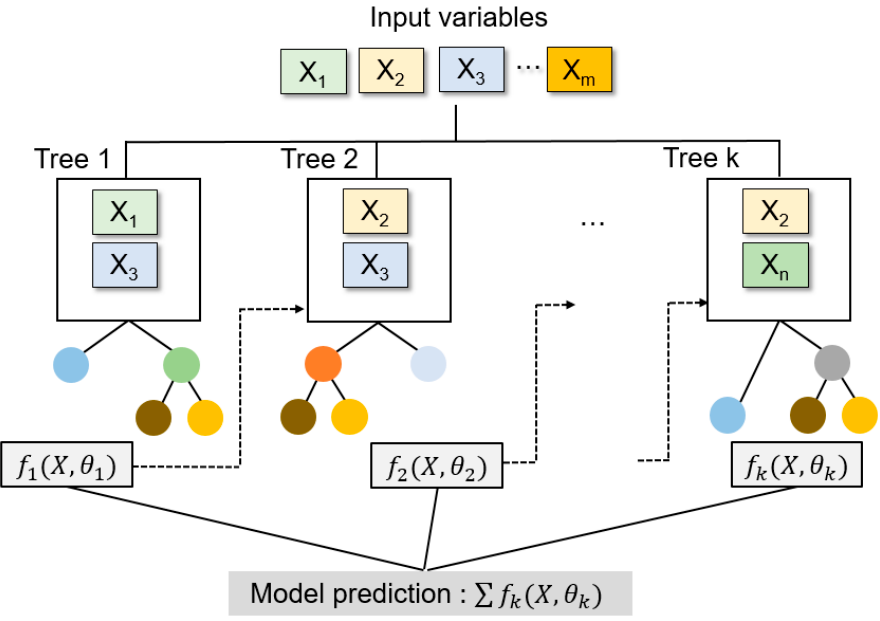
Figure 4. Schematic of the GBDT data processing.